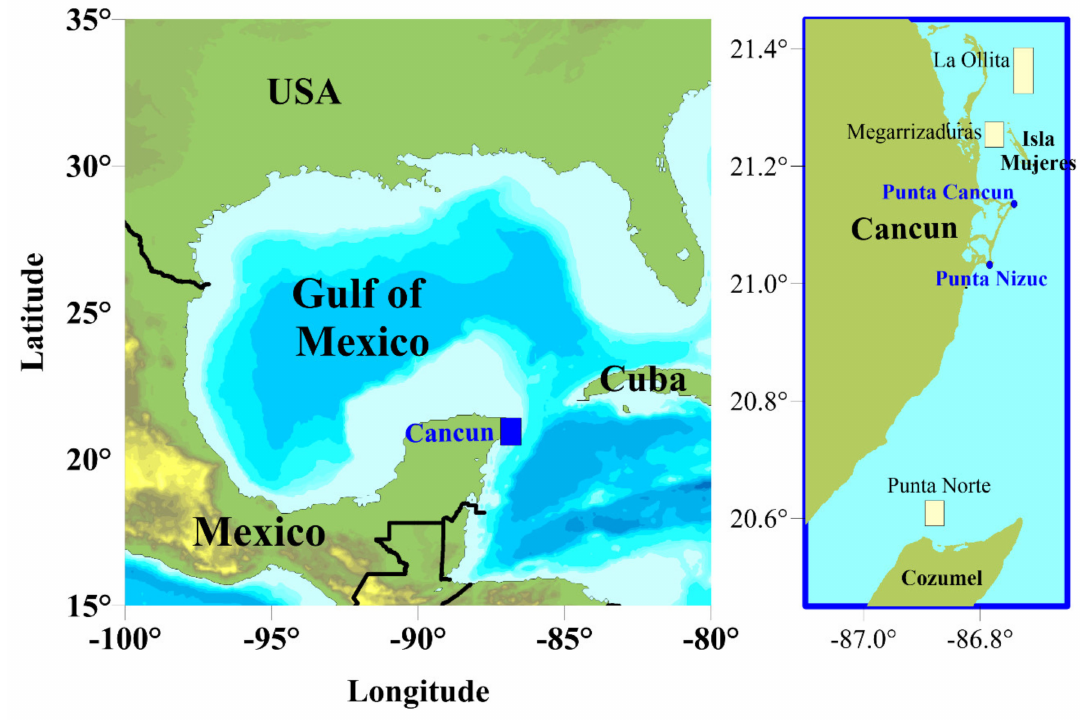
Figure 1. Location of the barrier island beach of Cancun, between Punta Cancun and Punta